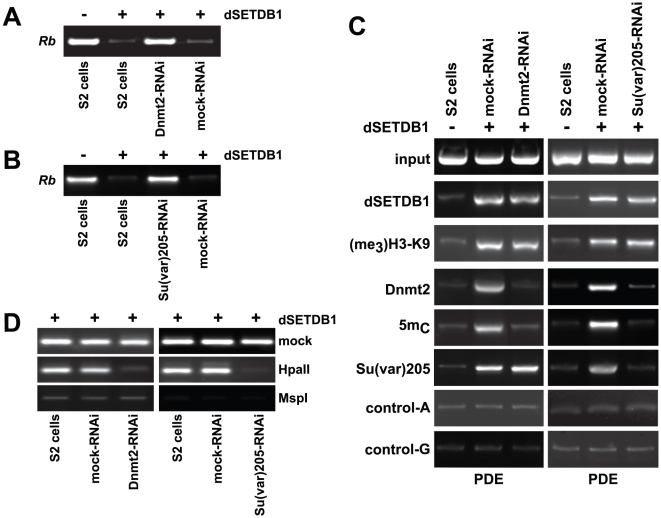
Dnmt2 and Su(var)205 cooperate with dSETDB1 in DNA methylation.(A) Digital images of ethidium bromide-stained agarose gels showing reaction products of PCR assays detecting Rb transcription in total RNA isolated from S2 cells, S2 cells expressing dSETDB1, and S2 cells transiently expressing dSETDB1 in the presence of small-interfering RNA (siRNA) targeting Dnmt2 (Dnmt2-RNAi) or control RNA targeting human GAPDH (mock-RNAi). (B) PCR assays as in (A) except that S2 cells were treated with siRNA targeting Su(var)205 [Su(var)205 RNAi]. (C) Digital images of ethidium bromide-stained agarose gels showing the presence of the PDE of Rb (Figure 5A) in DNA pools generated by ChIP with chromatin isolated from cells described in (a; left panel) and (b; right panel). Chromatin was immunoprecipitated with the antibodies and controls described in Figure 2C. (D) Digital images of ethidium bromide-stained agarose gels showing the reaction products of methylation-sensitive restriction analyses with genomic DNA isolated from cells described in (A,B). Assays were performed as described (Figure 5D). PCR assays detected the presence of PDE (Figure 5B) in treated DNA pools.